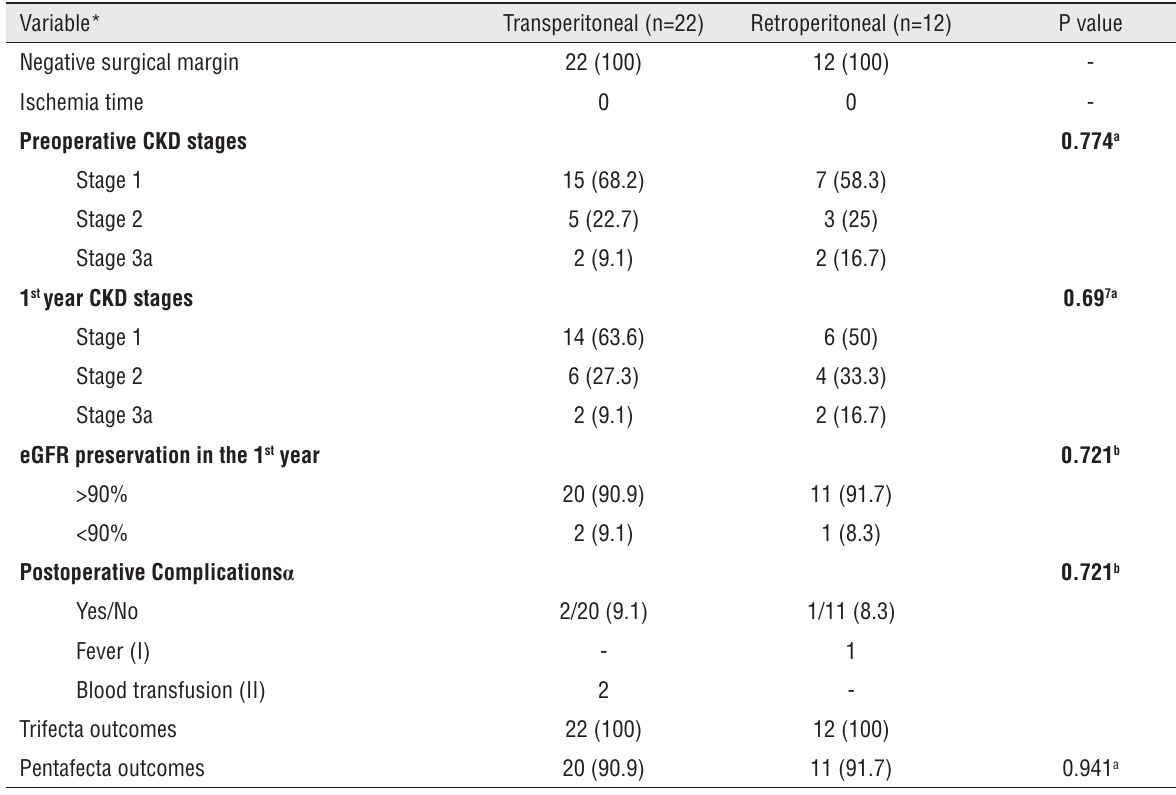
Table 3 - Trifecta and pentafecta